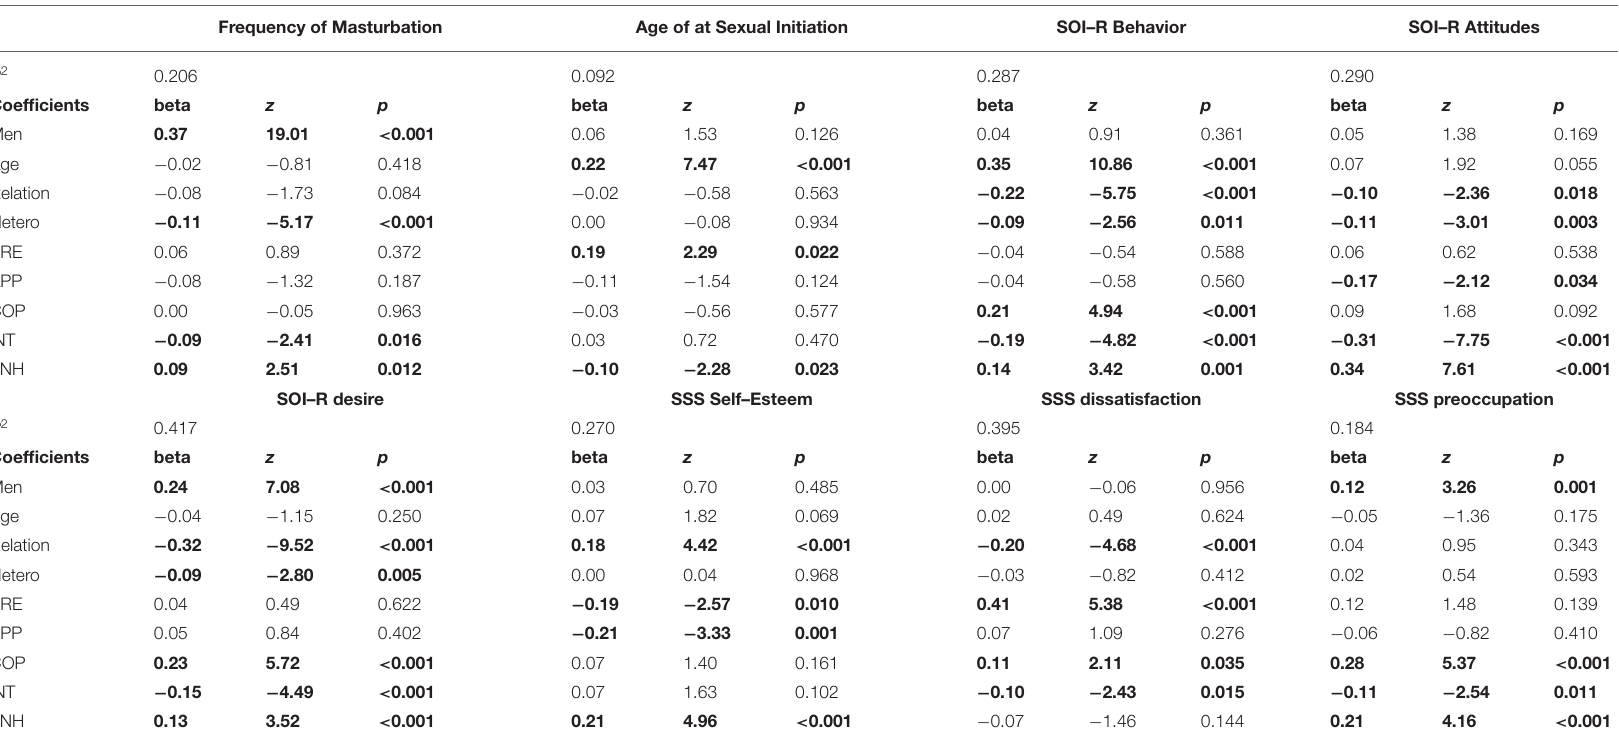
TABLE 4 | Structural model of the relationships between the five sexual motives and sociodemographic data with sexual behavior, sociosexuality, and psychosexual measures. Frequency of Masturbation Age of at Sexual Initiation SOI–R